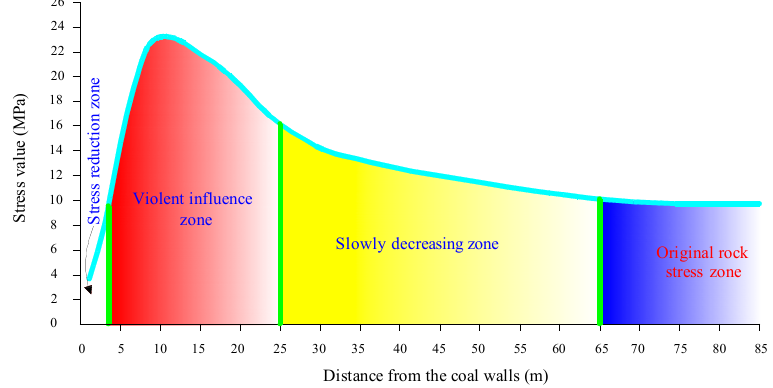
Figure 17. C haracteristics of the front abutment pressure zones of the large mining height coal face.